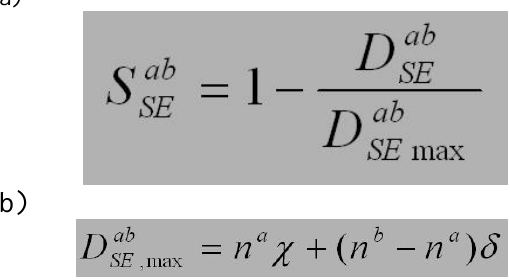
Fig 4: Editing operations for calculating the similarity index